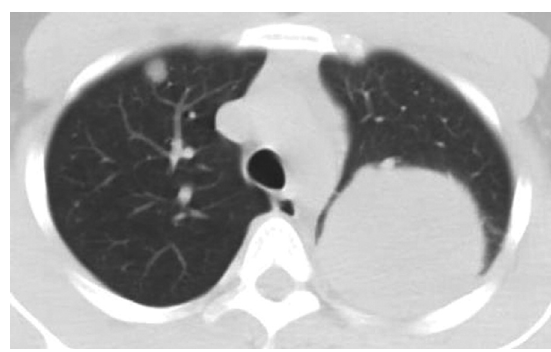
Computed tomography (CT) of the chest revealing a left upper lobe mass and two masses on the right side without